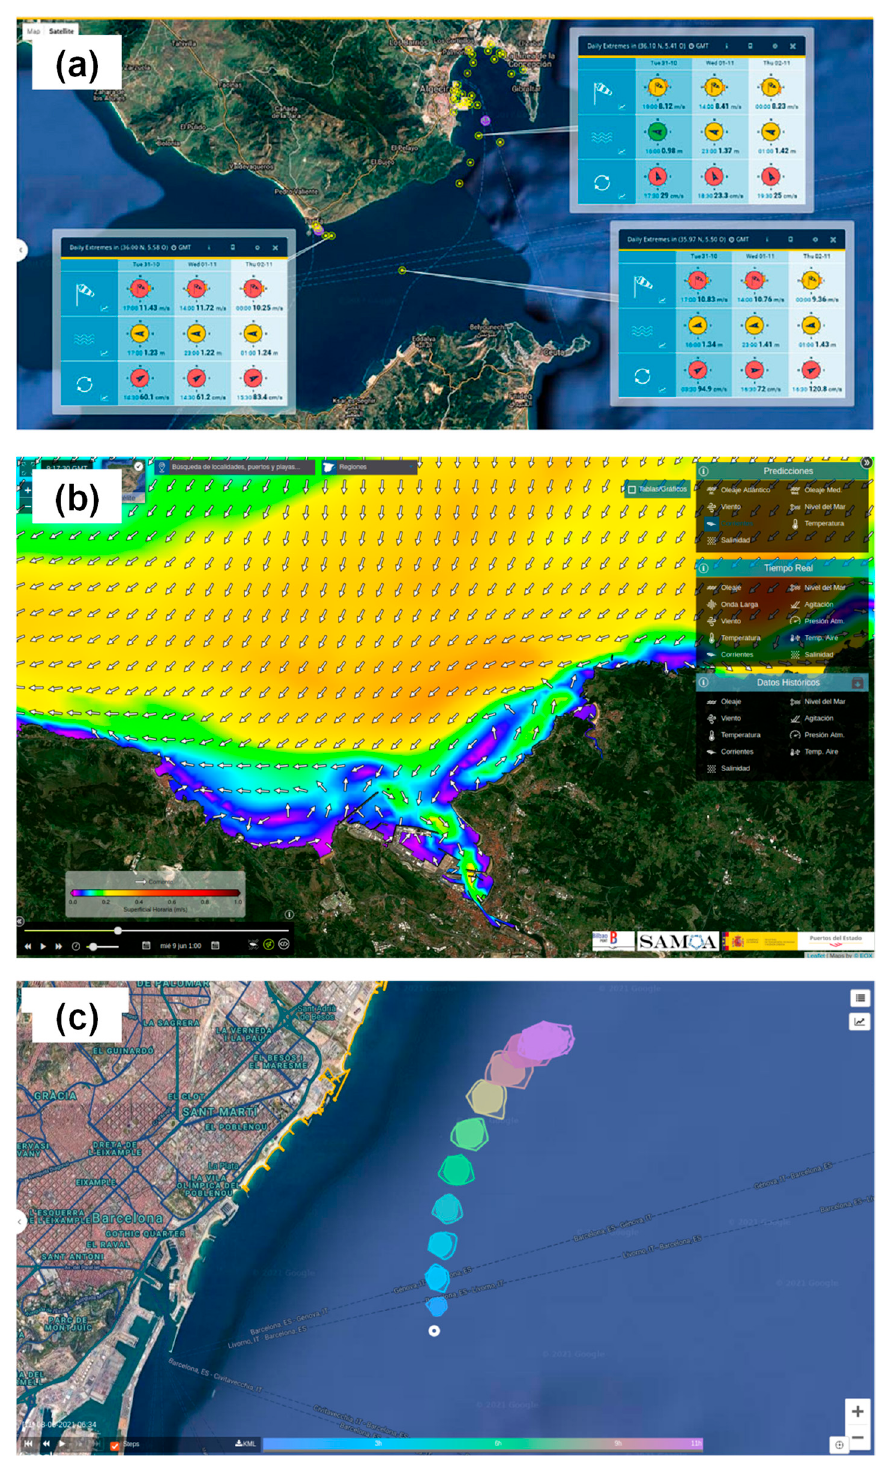
Figure 1. 3 Example of Port user ‐ oriented viewing capability through the SAMOA CMA environmental dashboard: ( a ) 3 ‐ days forecast information for wind, waves and currents at Algeciras Bay; Depicted maximum forecasted values and coloured end ‐ user alert symbols (green ‐ yellow ‐ red) following specific user ‐ customized alert thresholds at location of interest for the Port operations; ( b ): Map of SAMOA high ‐ resolution forecasted surface current field in nearby waters of the Bilbao Port. ( c ) Example of Oil spill forecast in front of Barcelona Port. Outputs from the PdE Oil Spill forecast service using SAMOA high resolution forecasted currents.